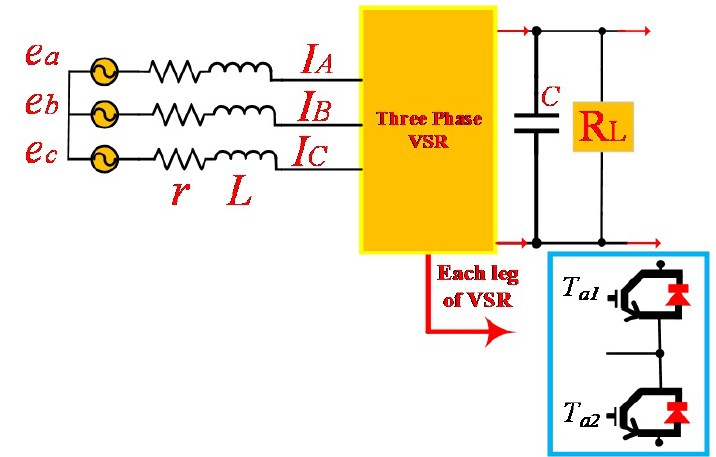
Figure 4. Three-phase voltage sensitive relay (VSR)